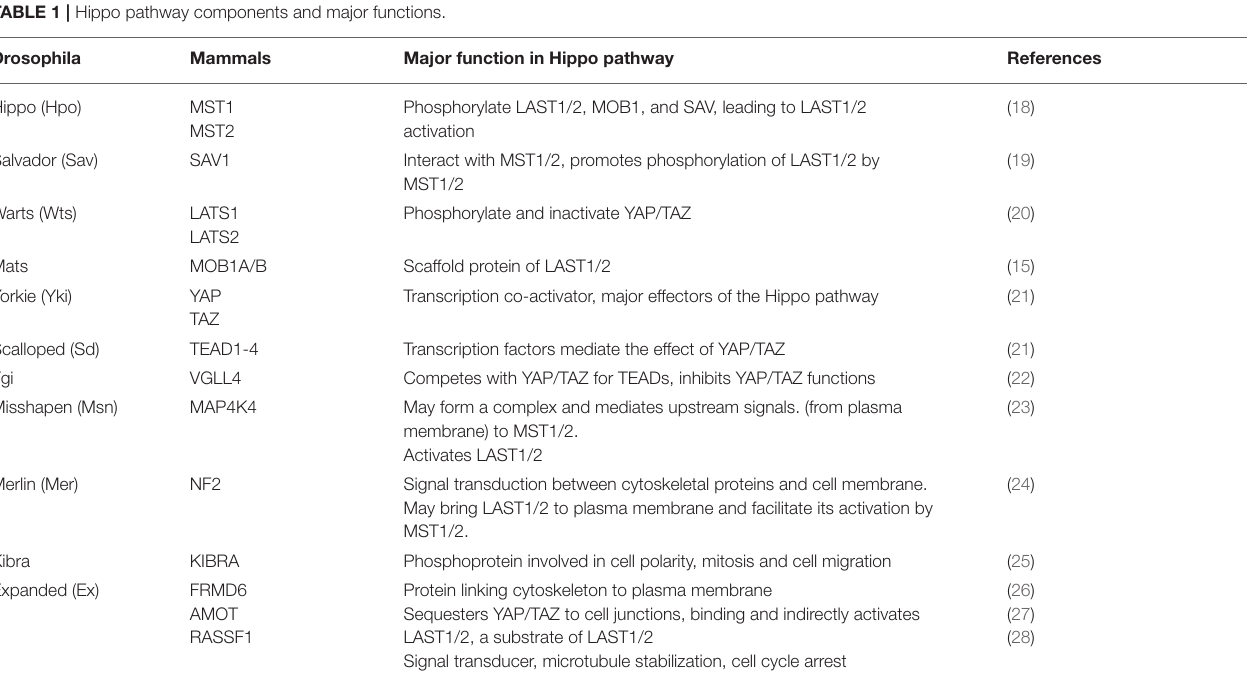
TABLE 1 | Hippo pathway components and major